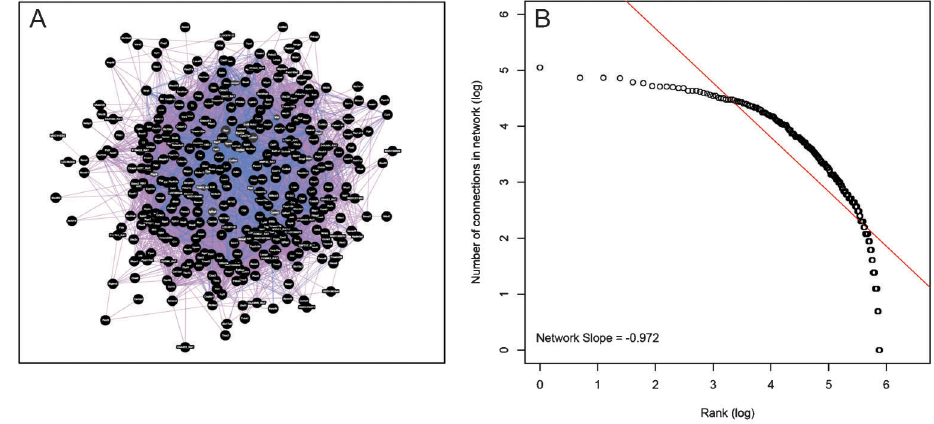
Figure 3. A , The top 200 upregulated and top 200 downregulated genes in the male dataset were filtered and the gene symbols extracted and presented to the free internet-based program GeneMANIA (www.genemania.org). B , When the frequency of gene appearance was ranked and used to construct the log rank-log expression graph, the exponent was close to ––1.